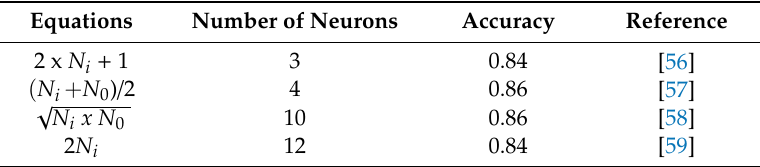
Table 3. Grid search values for Artificial Neural Networks